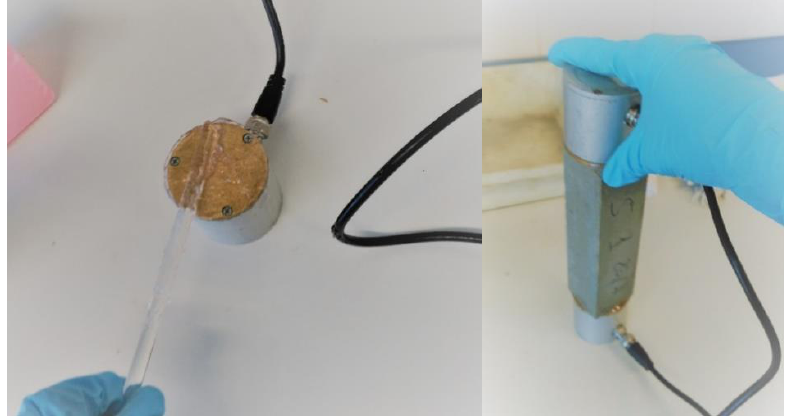
Figure 1. Measurement of the propagation time of the ultrasonic waves through the specimen.